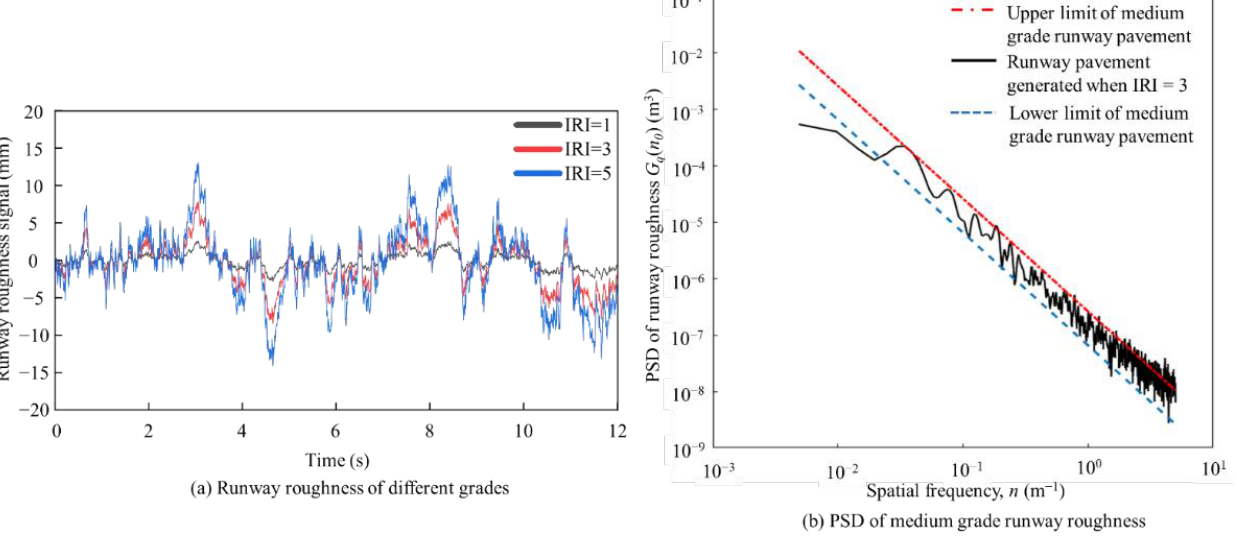
Figure 2. The roughness curve of pavement and the power spectrum density (PSD) of pavement were verified. were